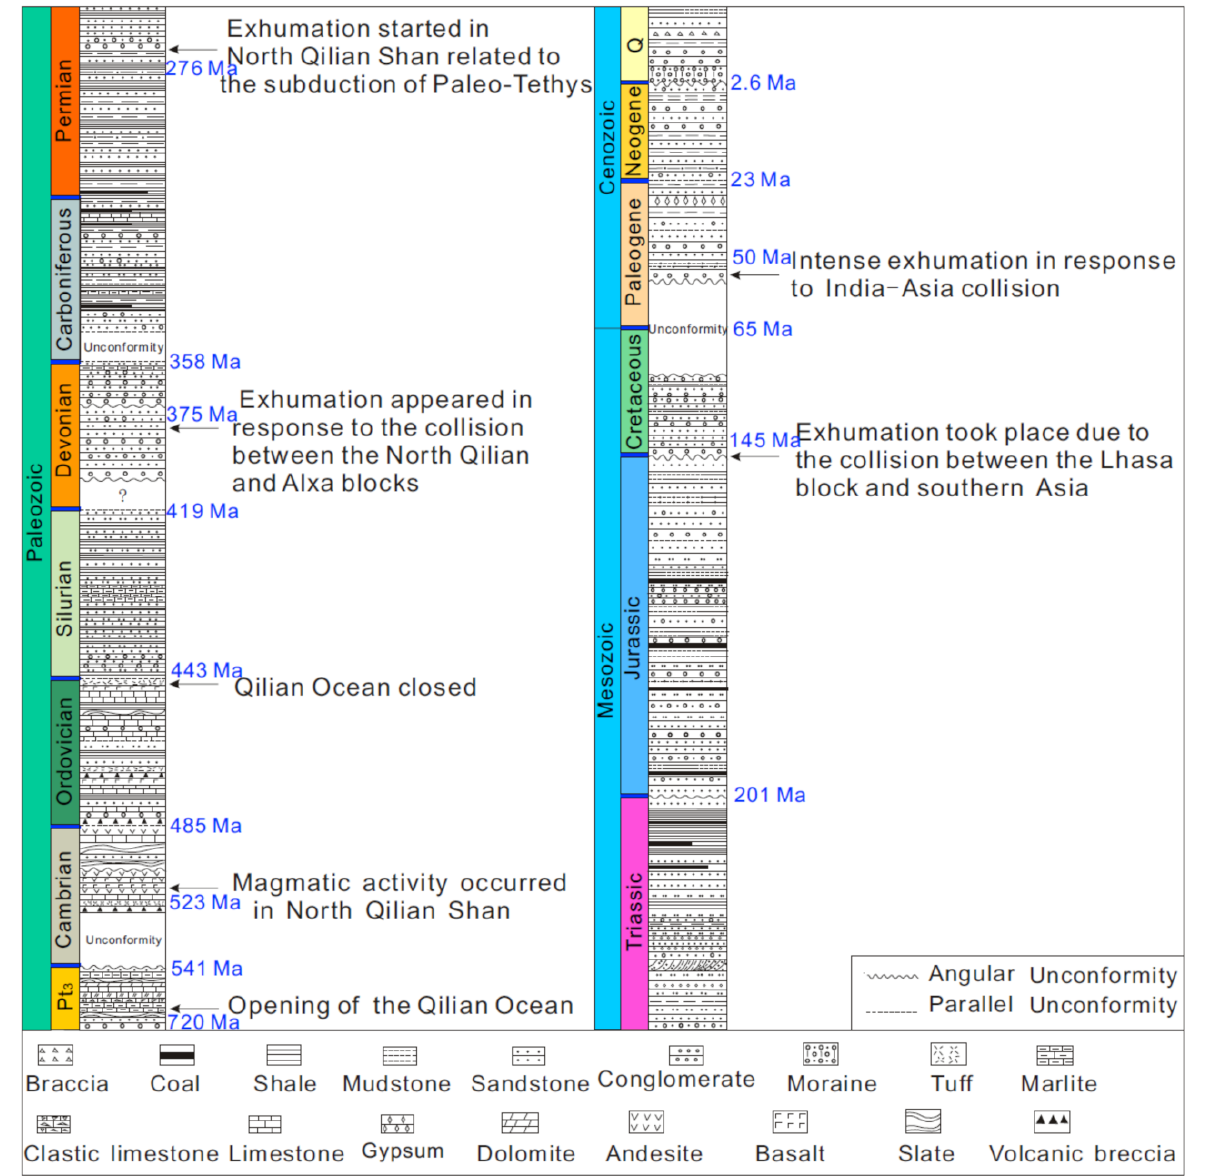
Figure 4. Regional stratigraphy and tectonic evolution in the North Qilian Shan